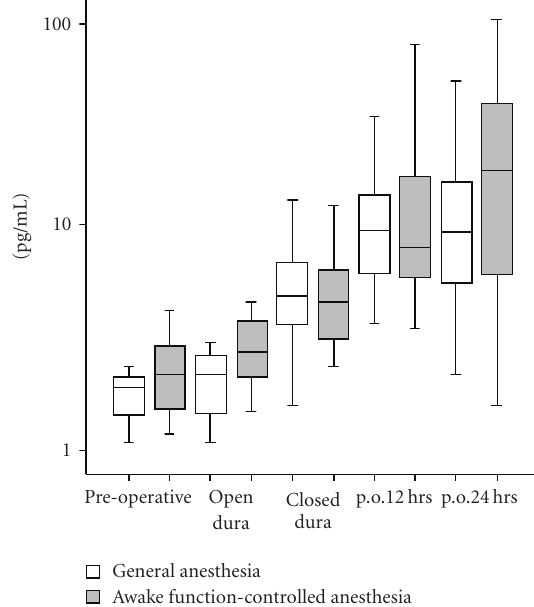
Figure 1: Box plots of plasma IL-6 levels . A significant IL-6 level increase is found in both experimental groups F(1.336, 49.416) = 24.148, P < . 001. No significant plasma IL-6 level di ff erence is found between